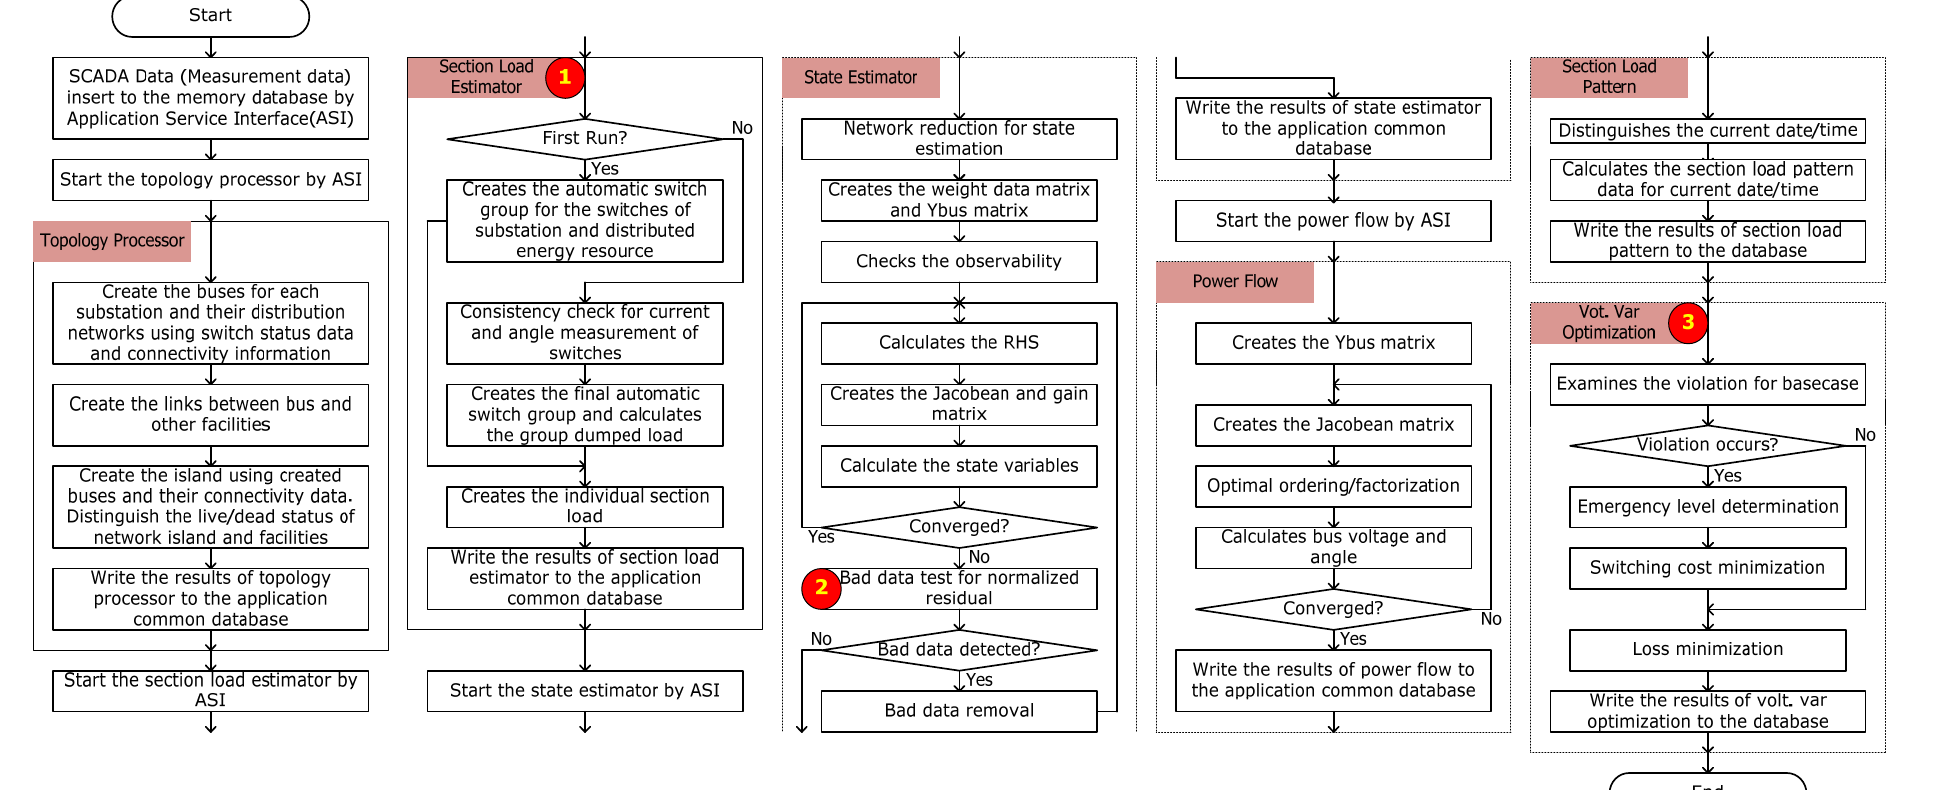
Figure 4. Flowchart of KSDMS real-time mode